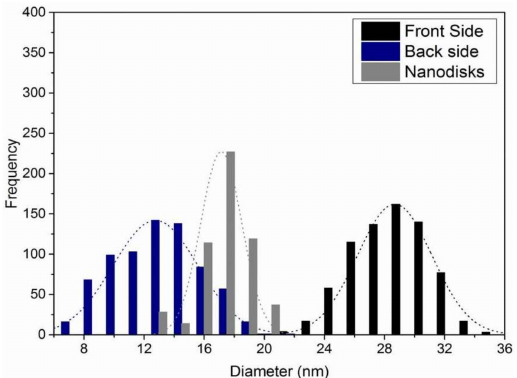
Figure 4. Distribution of the pore diameters for the top side (black bars) and the back side (blue bars) of the SSM. The grey bars represent the distribution of the diameters of the viral nanodiscs. A Gaussian distribution function is fitted to the three size